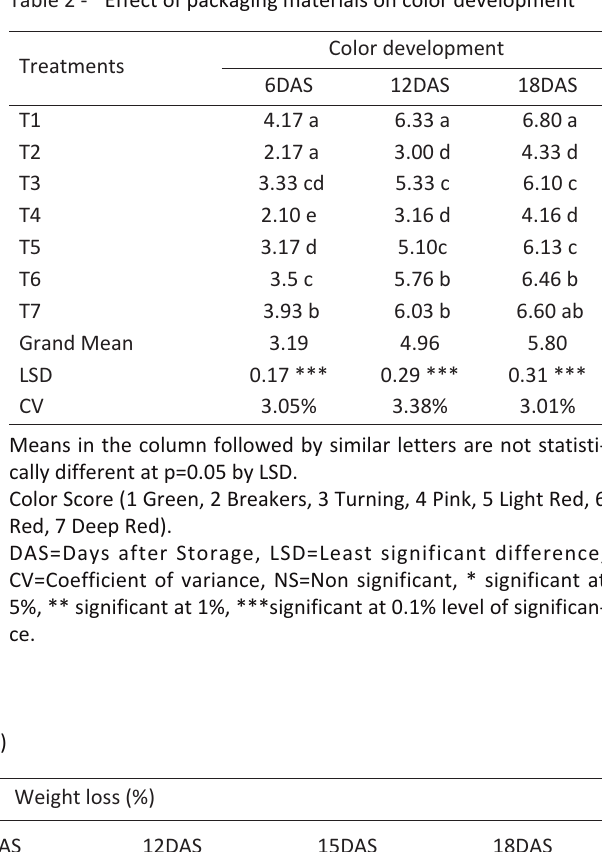
Table 2 ­ Effect of packaging materials on color development